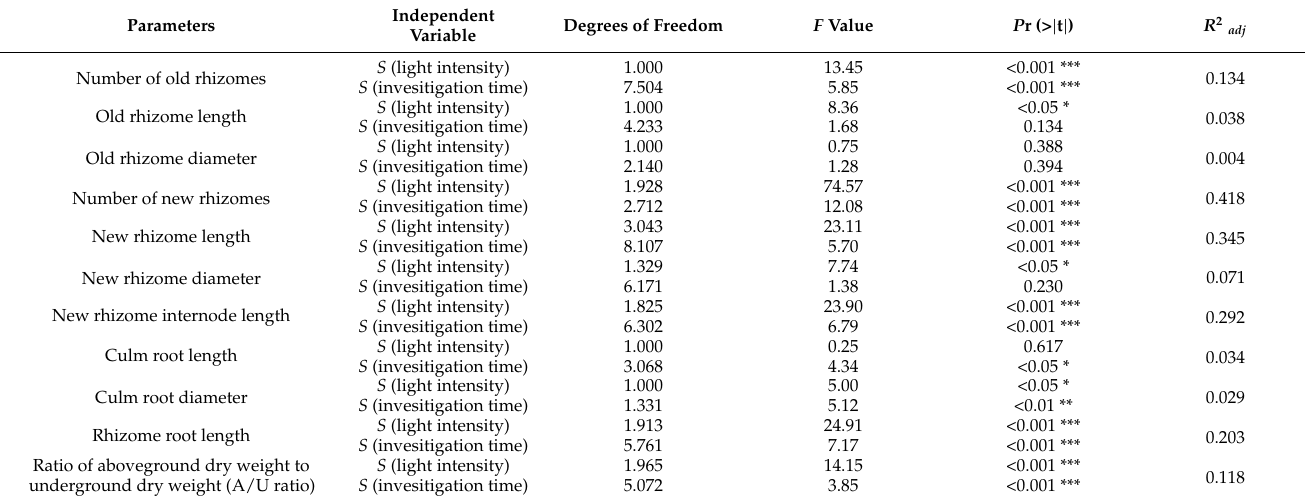
Table 1. Results from the generalized additive models (GAMs) in explaining the influence of light intensity and investigation time on the rhizomes’ and roots’ growth of P. pygmaeus plants. *** p < 0.001; ** p < 0.01; * p <